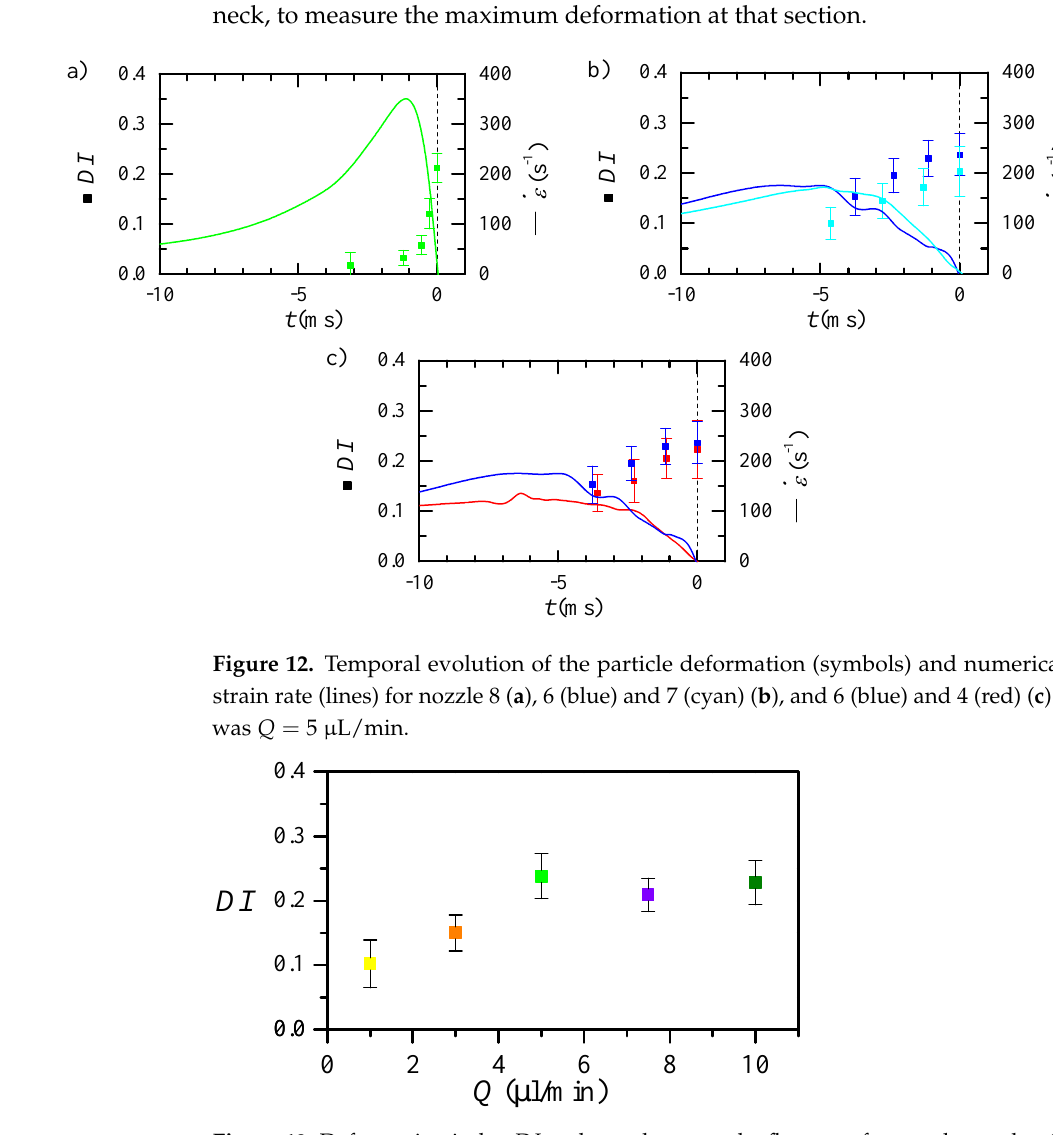
Figure 13. Deformation index DI at the neck versus the flow rate for nozzle number 8.